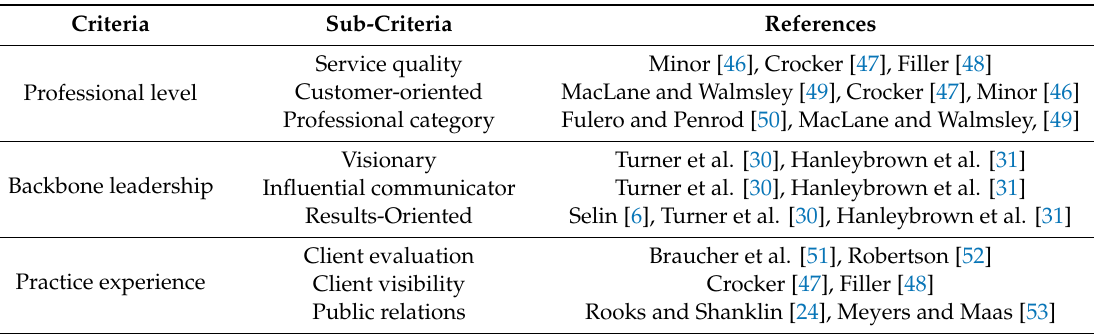
Table 6. Criteria refined by the